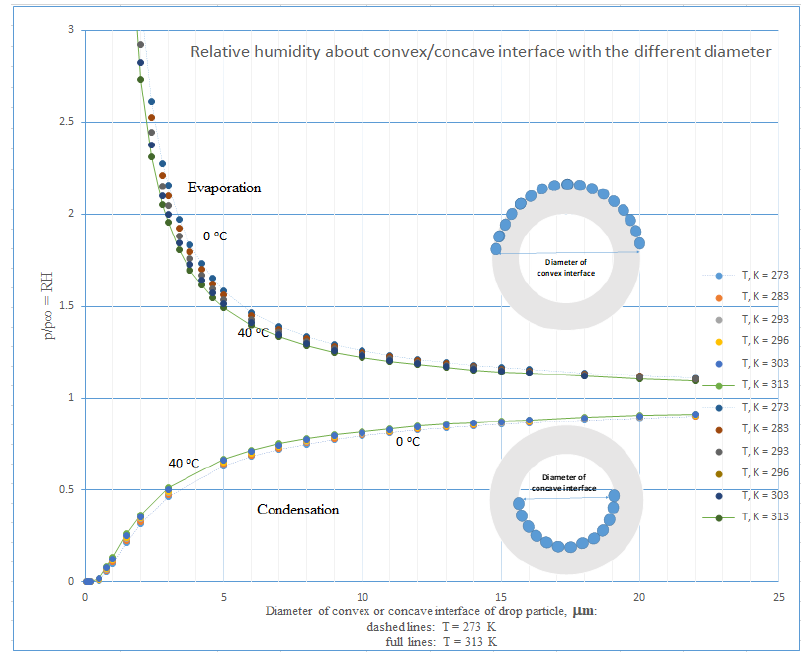
Figure A2. Relative humidity, RH over water surfaces with convex/concave curvature enabling water molecules to evaporate (convex interface) or to condensate (concave interface) vs. diameter of droplets with water shells at constant temperature.